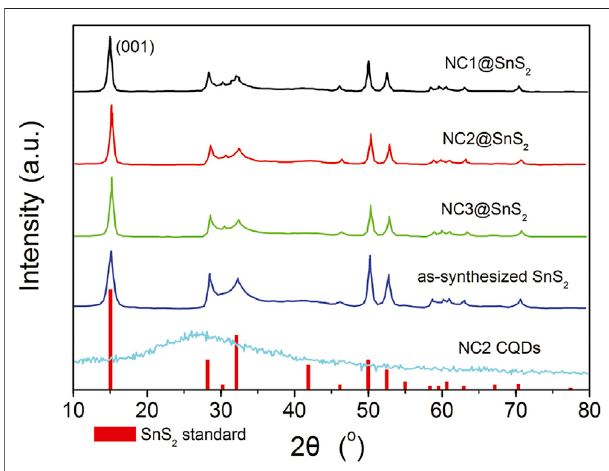
FIGURE1| XRDpatternsofSnS 2 (standardJCPDSCardNo.23-0677), as-synthesized SnS 2 in this work, and NC@SnS 2